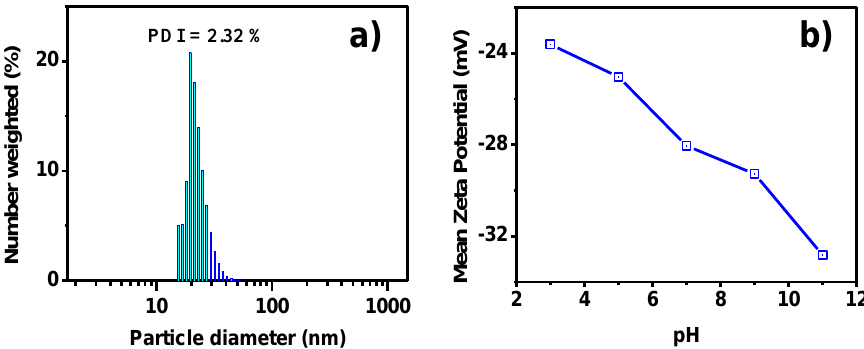
Figure 4. ( a ) DLS histogram and ( b ) zeta potential analysis of AuNPs synthesized with water/ethanol Sargassum spp. extract.